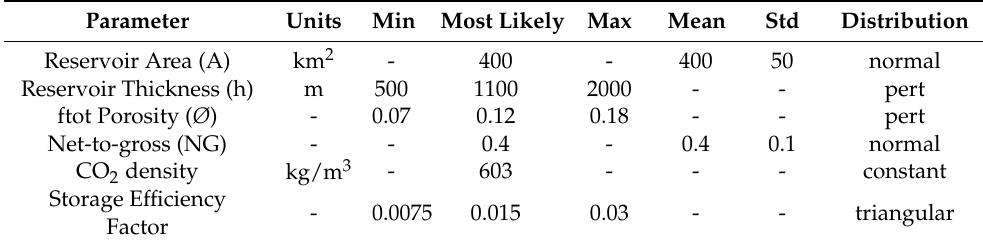
Table 8. Parameter distribution for the Eptachori